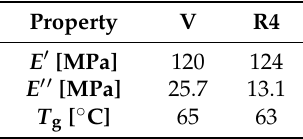
Table 2. Dynamic-mechanical thermal (DMTA) results for pristine and reprocessed